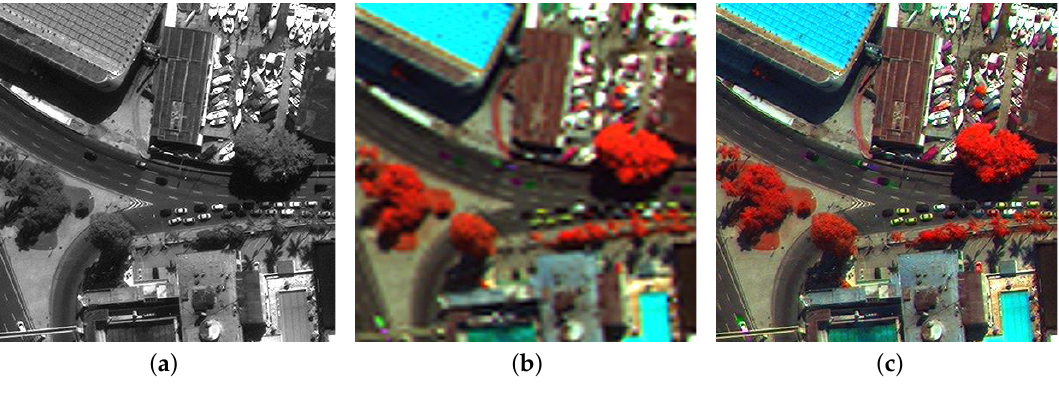
Figure 13. ( a ) PAN; ( b , c ) the eighth, the third, and the first band for false color composite; ( b ) MS;